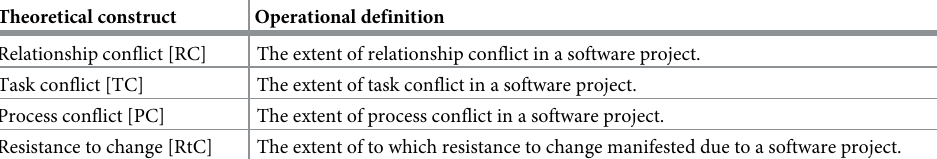
Table 1. Definitions of theoretical